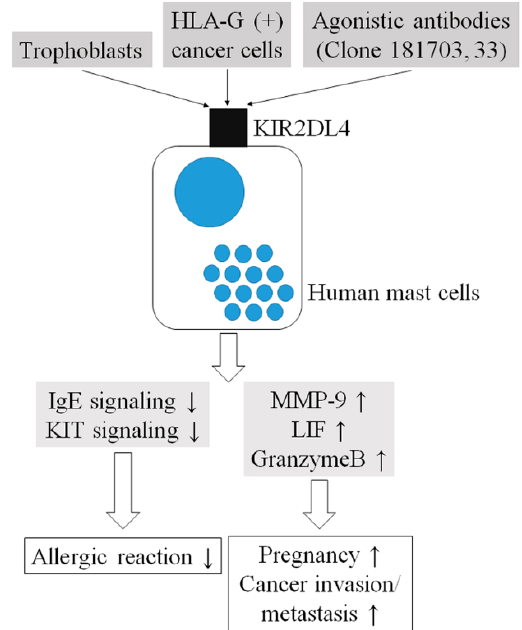
Figure 2. The current model. HLA: human leukocyte antigen; KIR: killer immunoglobulin-like receptor; LIF: Leukemia inhibitory factor; MMP: matrix metalloprotease.